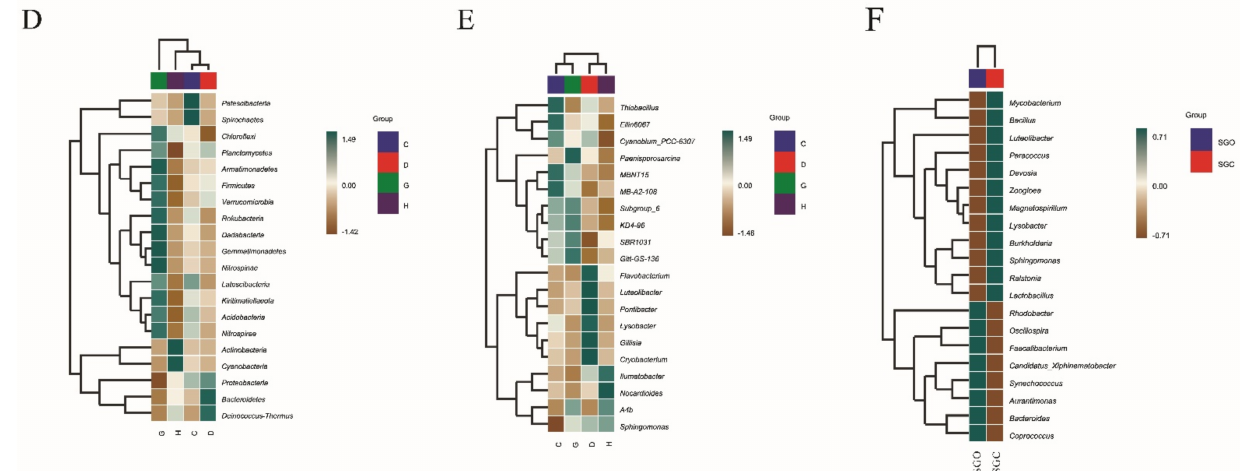
Figure 3. Correlation analysis of microbial communities in shrimp farm samples with different oxygenator conditions. ( A ) Phylum level in water. ( B ) Genera level in water. ( C ) Species level in water. ( D ) Phylum level in sediment. ( E ) Genera level in sediment.